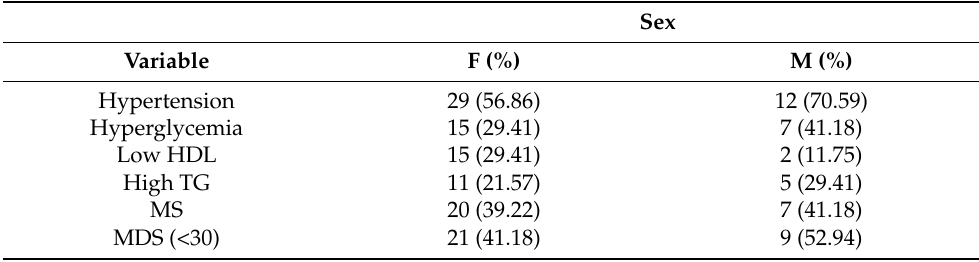
Table 3. Distribution of patients of the whole sample, and divided by sex (female n = 51, male n = 17) showing hypertension, hyperglycemia, abnormal levels of high density lipoprotein (HDL) and triglycerides (TG), metabolic syndrome (MS), and lower adherence to the Mediterranean Diet (MDS) based on their clinical, metabolic and nutritional